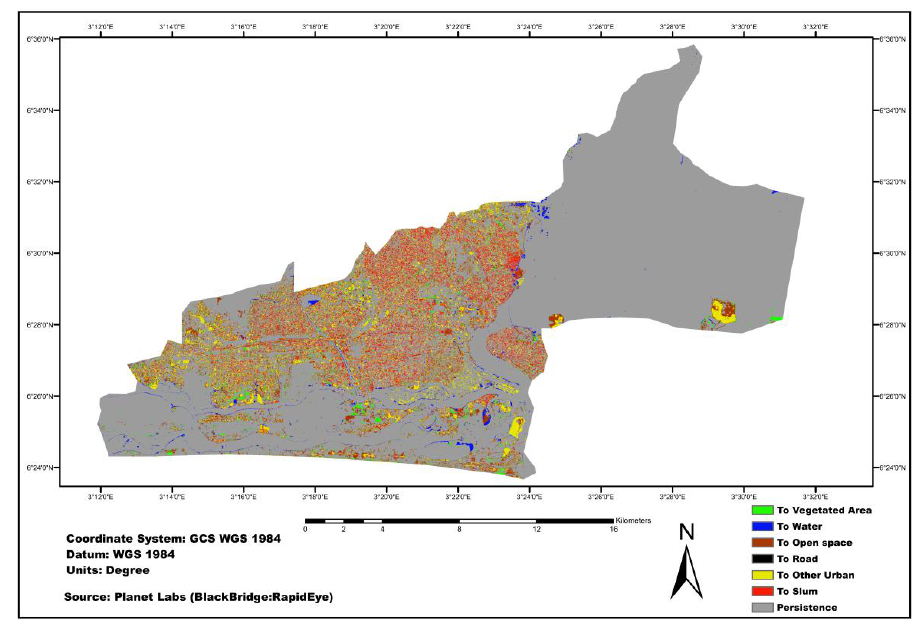
Figure 6. Detected changes in the research area between 2009 and 2015. Remote Sens. 2017 , 9 , x FOR PEER REVIEW